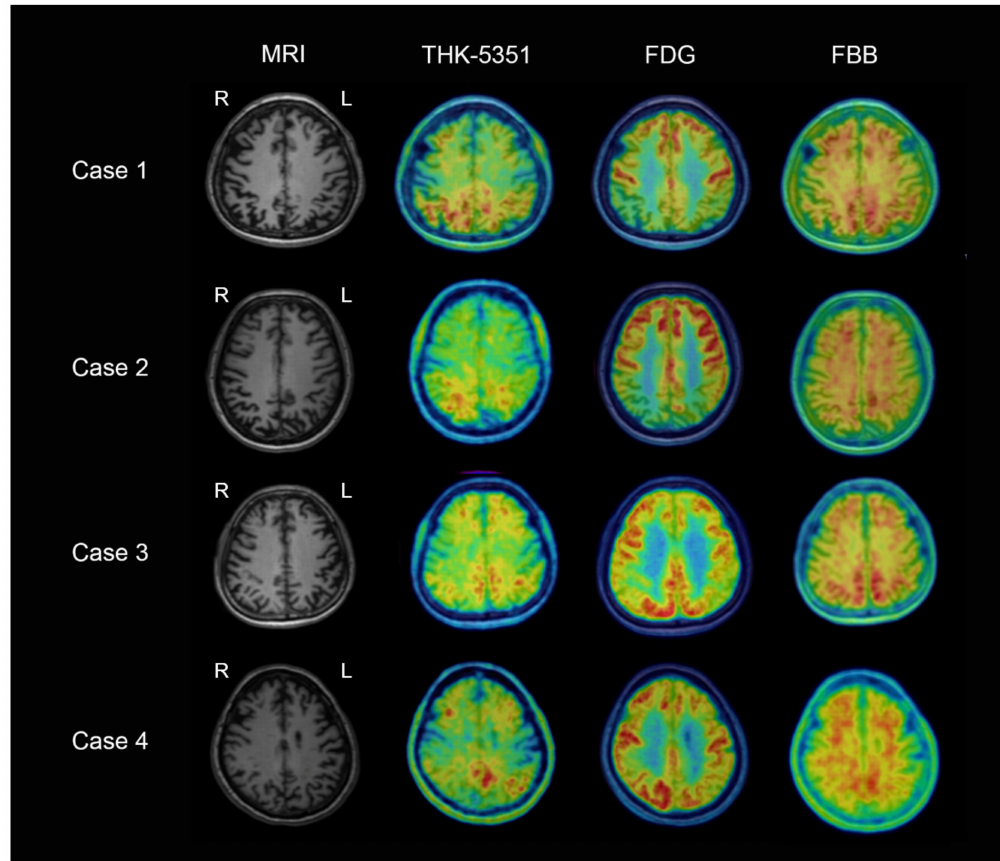
Figure 1. Axial structural magnetic resonance imaging (MRI) and three positron emission tomography (PET) images using 18 F–THK–5351, 18 F–Fluorodeoxyglucose, and 18 F–Florbetaben in atypical Alzheimer’s disease cases. Cases 1 and 2: Posterior cortical atrophy patients demonstrating bilateral parieto-occipital cortical atrophy on structural MRI scan, parieto-occipital and frontal tau accumulation (posterior>frontal) on 18 F–THK–5351 PET, glucose hypometabolism in both fronto-parieto-temporal association cortices, including the posterior cingulate cortex, on 18 F–FDG PET, and increased amyloid uptake in diffuse cortices on 18 F–FBB PET images. Cases 3 and 4: Logopenic variant primary progressive aphasia patients showing left temporo-parietal atrophy on structural MRI scan, temporo-parietal and frontal tau depositions (Left > Right) on 18 F–THK–5351 PET, decreased glucose metabolism in bilateral temporo-parietal (Left > Right) and left frontal cortices on 18 F–FDG PET, and widespread amyloid deposits on 18 F–FBB PET